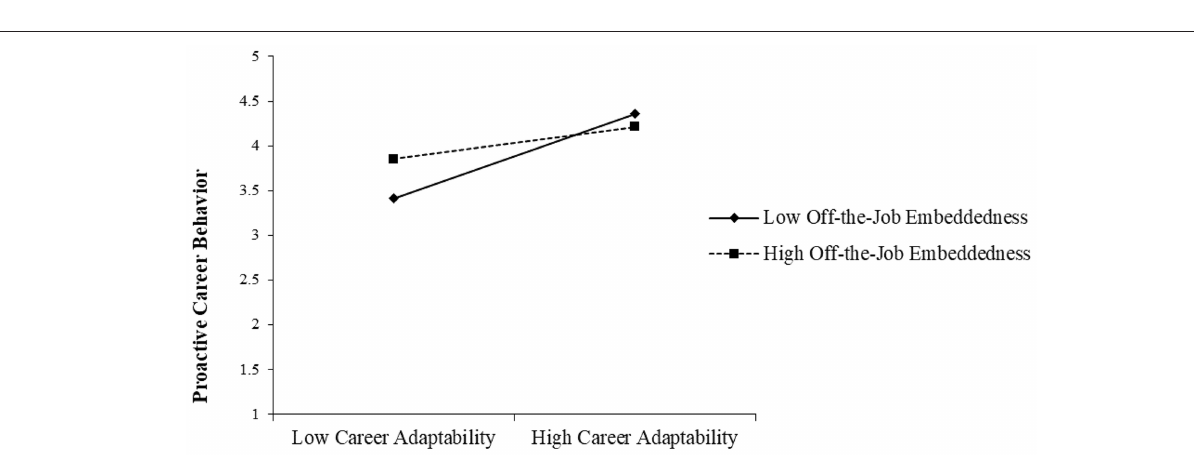
FIGURE 3 | The effect of career adaptability on proactive career behavior at high and low levels of off-the-job embeddedness. The simple slope tests showed that the relationship between psychological safety and prohibitive voice behavior was more positive for individuals with low off-the-job embeddedness ( b = 0.44, p < 0.001) than for individuals with high off-the-job embeddedness ( b = 0.22, n.s.